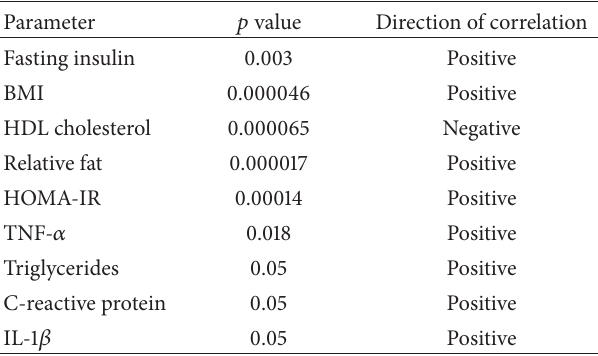
Table 1: Parameters of the metabolic syndrome are associated with high ADAM19 expression in human peripheral blood mononuclear cells ( 𝑛 = 1240